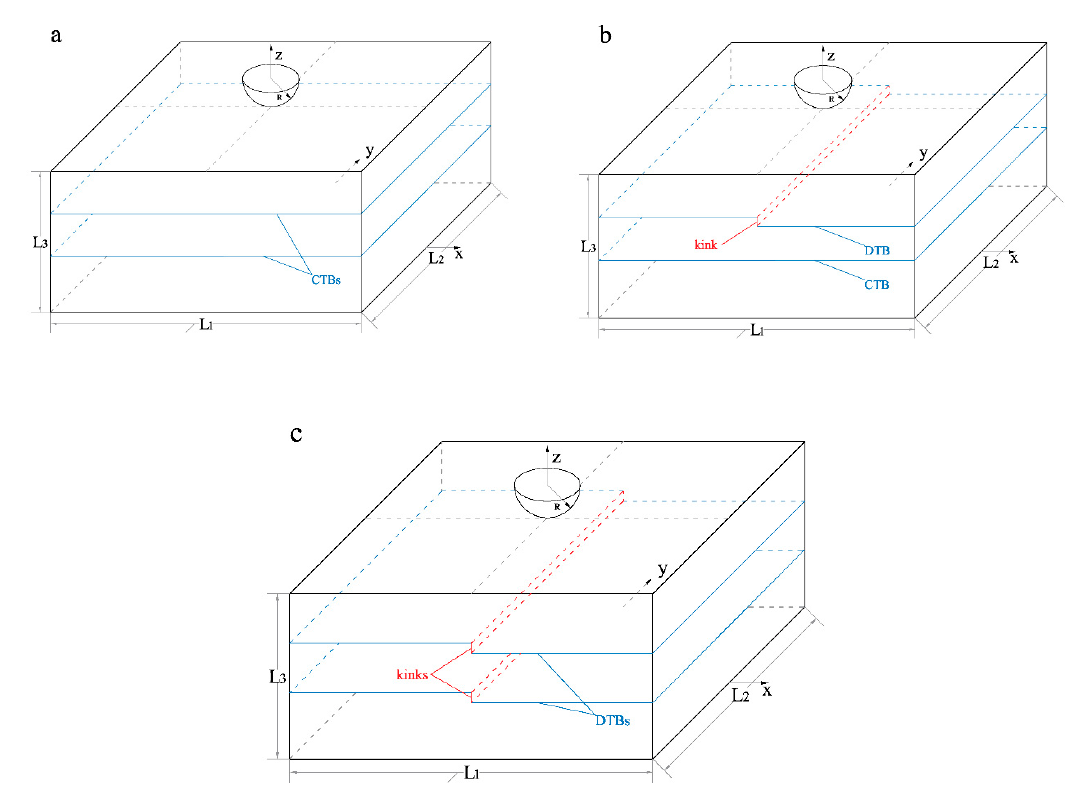
Figure 1. Schematic representation of nanoindentation with different models. ( a ) Two perfect twin (TPT) model, ( b ) single defective twin (SDT) model, and ( c ) two defective twin (TDT) model.